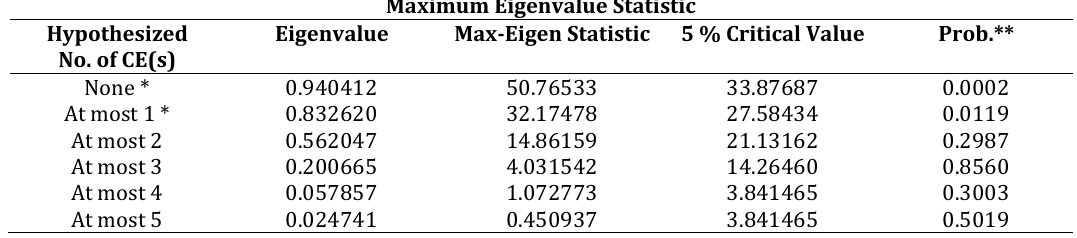
Table 3: Johansen co-integration test using Max-Eigen Statistic Maximum Eigenvalue